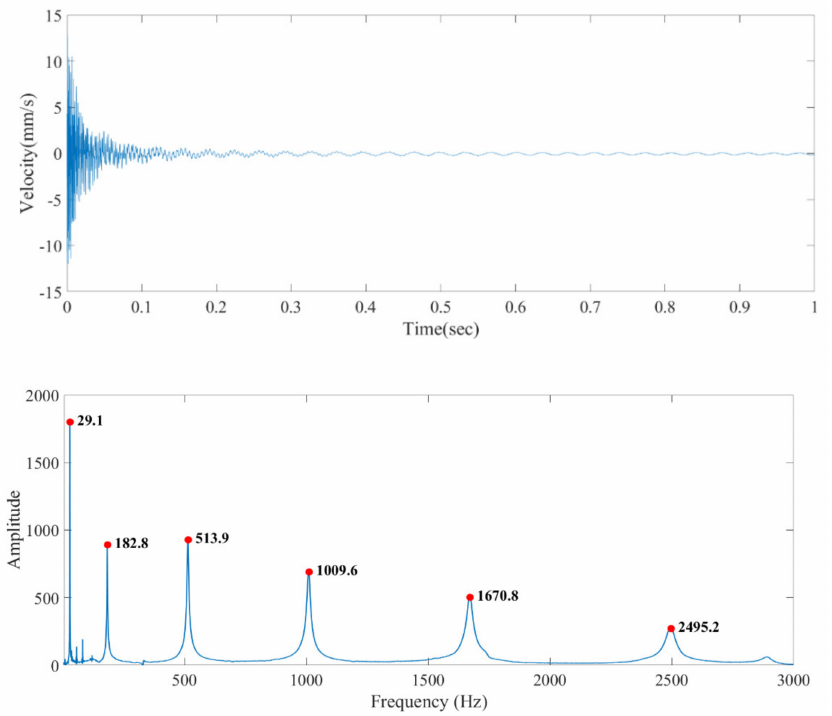
Figure 4. Time domain and frequency domain signals of xy plane– x direction test piece when hitting point